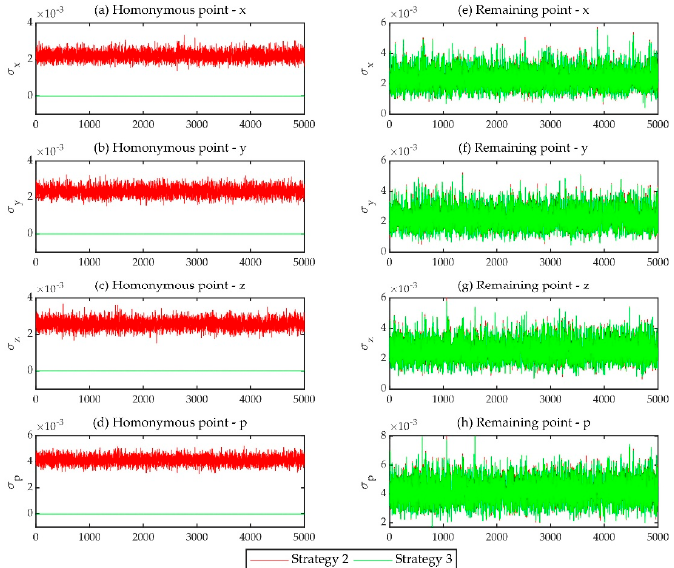
Figure 7. RMSE of points in Case 2 where the horizontal axis indicates the experimental serial number. ( a ) RMSE of homonymous points in x direction; ( b ) RMSE of homonymous points in y direction; ( c ) RMSE of homonymous points in z direction; ( d ) positional RMSE of homonymous points; ( e ) RMSE of checking points in x direction; ( f ) RMSE of checking points in y direction; ( g ) RMSE of checking points in z direction; ( h ) positional RMSE of checking points. Remote Sens. 2020 , 12 , x FOR PEER REVIEW